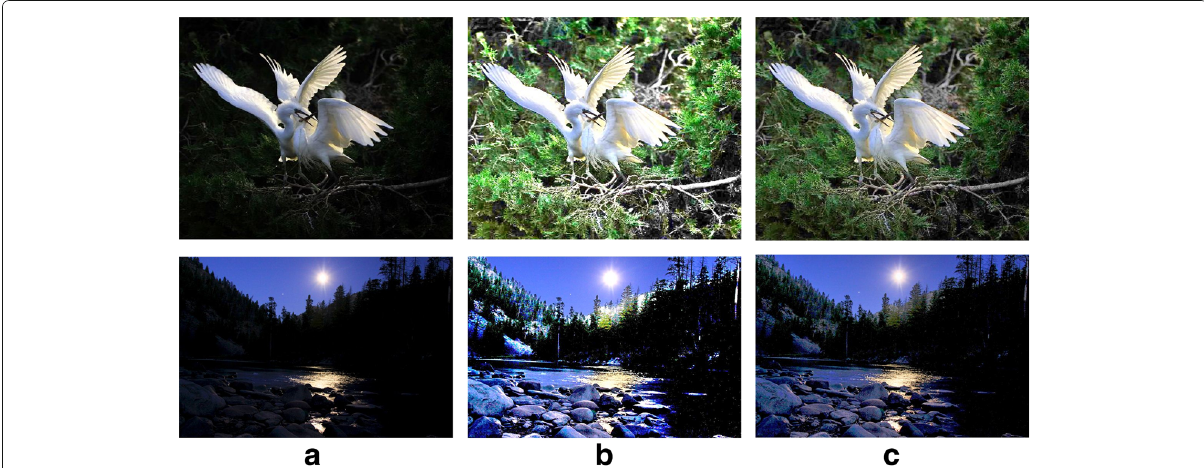
Fig. 13 Comparison of the proposed method with LIME [23]. a Input images. b Enhanced images with LIME [23]. c Enhanced image with the proposed